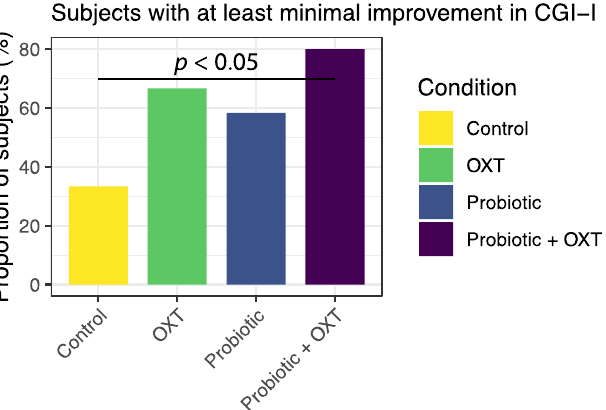
Figure 2. Proportion of subjects displaying improvement in CGI-I overtime among all subjects within a treatment condition. The z-test for equality of proportions is applied and the number of subjects displaying at least minimal improvement (CGI-I ≤ 3) in the control condition and the probiotic + OXT condition is significantly different ( p < 0.05), while the changes of probiotic and OXT alone groups are non-significant, though a trend of improvement is seen in both intervention